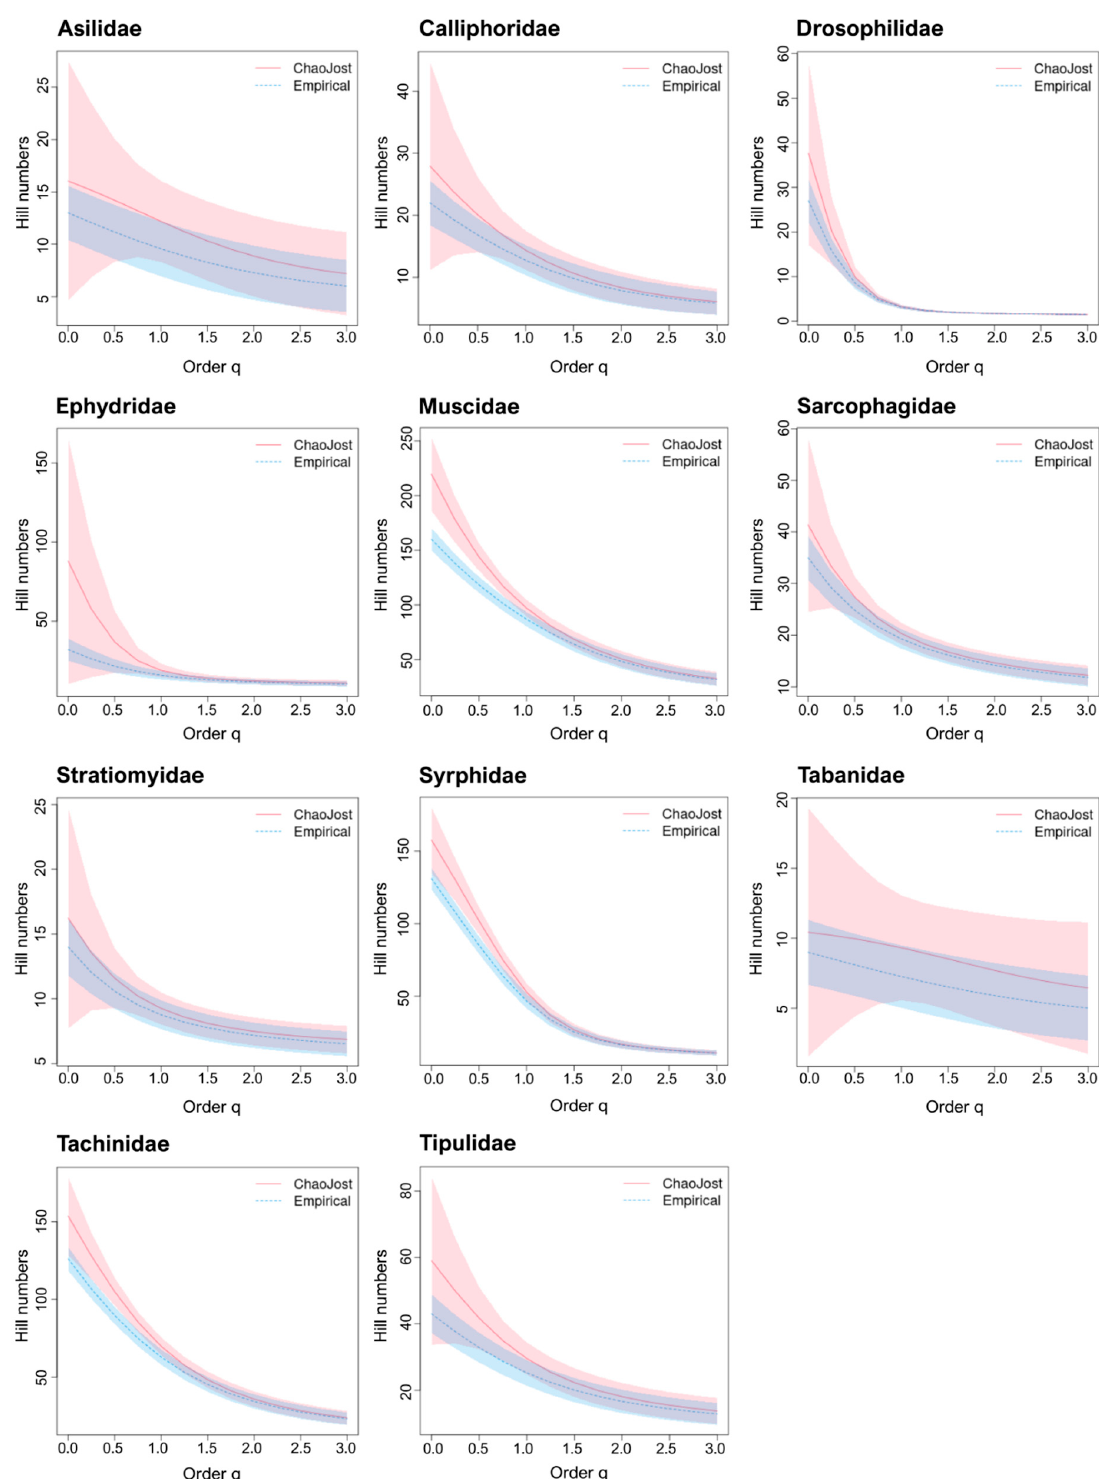
Figure 3. Diversity profiles for 11 well-known taxa. The empirical (BIN counts; dotted blue) and estimated (Chao1; red) diversity profiles for communities where Malaise traps were deployed, as quantified by Hill numbers for each of the 11 well-known families for values of the diversity order (q) from 0–3 with 95% confidence intervals (shaded areas based on bootstrap analysis of 100 permutations). Species richness is depicted by q = 0; Shannon diversity by q = 1; and Simpson diversity by q = 2.